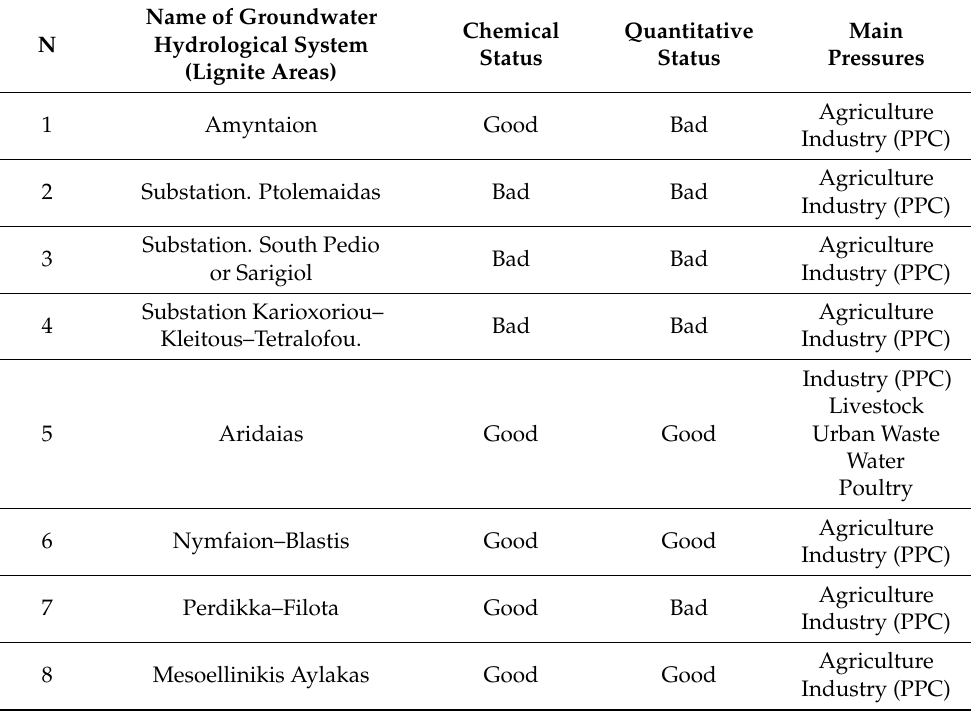
Table 3. Chemical and quantitative status of groundwater at lignite areas hydrological